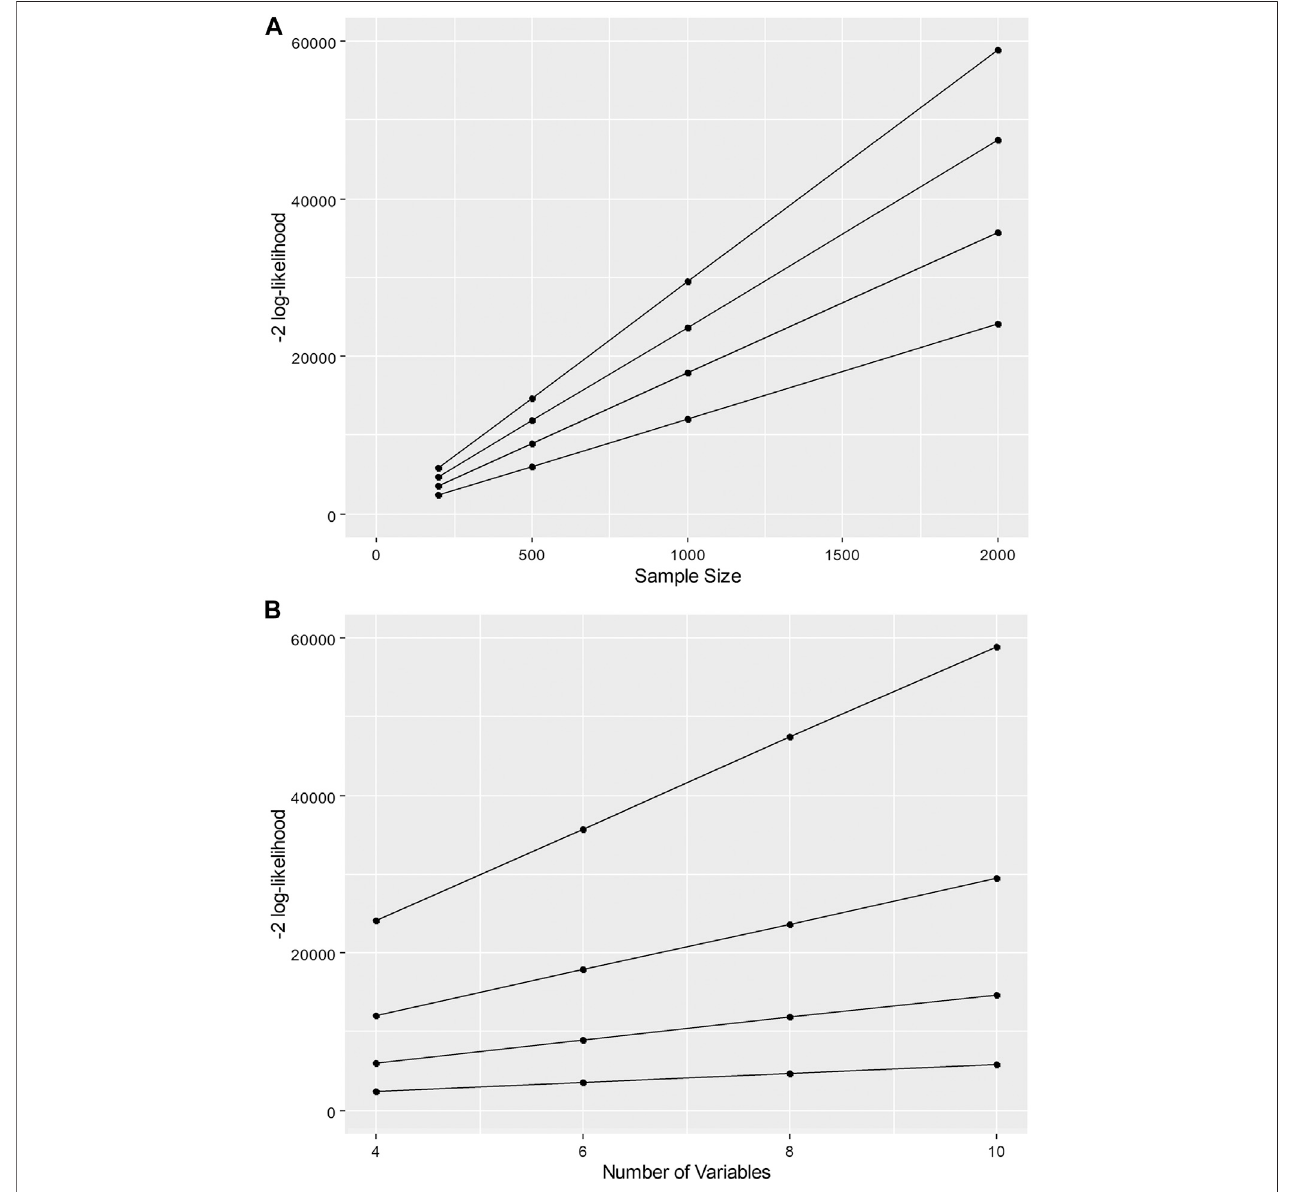
FIGURE 1 | − 2 log-likelihood as a function of (A) sample size and (B) number of variables in latent pro fi le analysis given a constant difference in a two-class